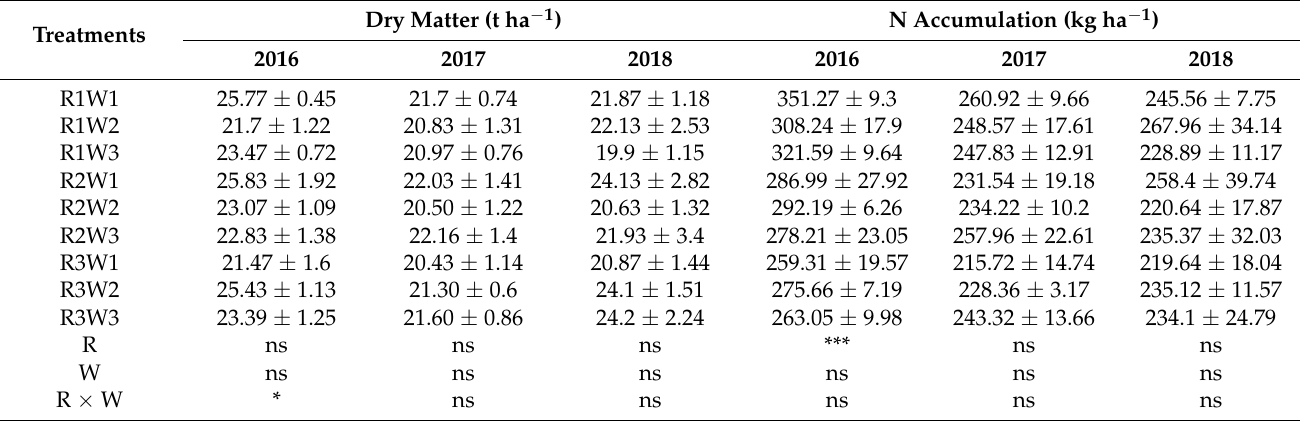
Table 4. Dry matter accumulation and N accumulation at maturity under different N rates in three rice seasons